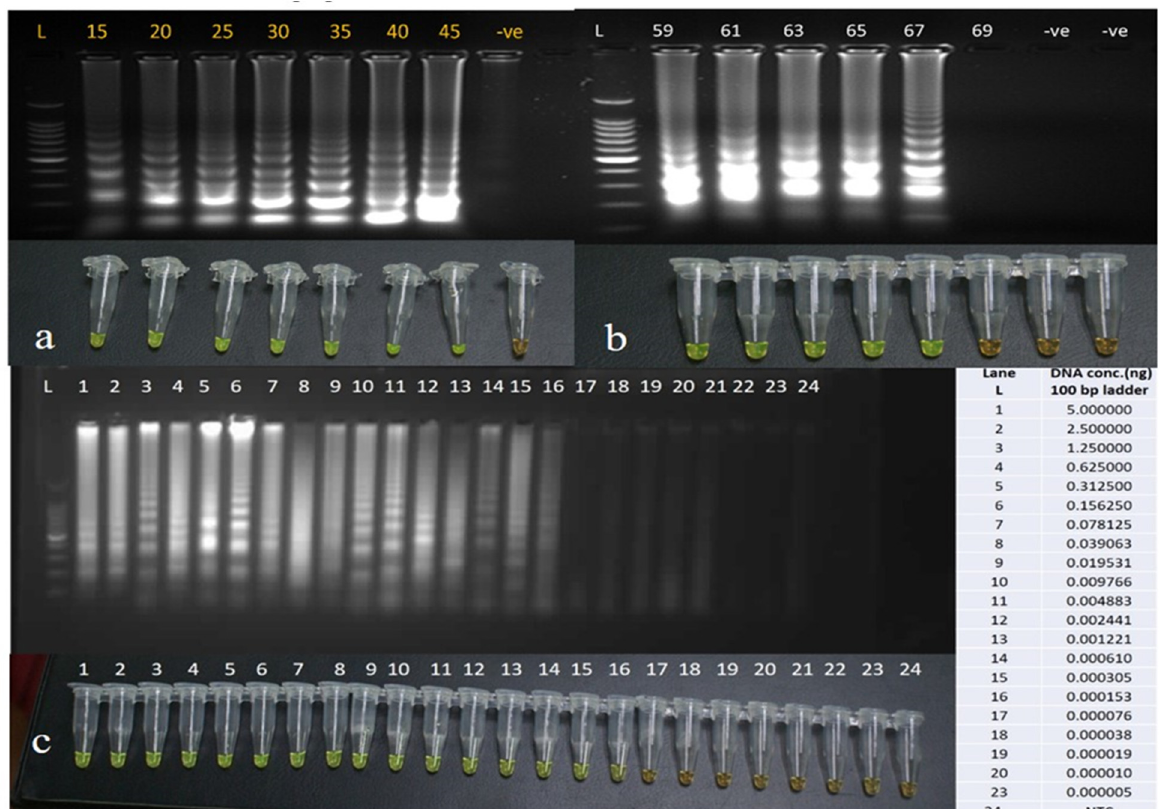
Figure 3. ( a ) Gel image and tubes of LAMP reaction showing naked eye visualization with SYBR green for standardization of time for amplification. ( b ) Gel image and tubes of LAMP reaction showing naked eye visualization with SYBR green for the standardization with different temperatures ranging from 59 to 69 °C. ( c ) Gel image and tubes of LAMP reaction showing visualization with the naked eye with SYBR green for standardization with different concentration of genomic DNA ranging from 5 ng to 0.000005 ng. L- 100 base pair ladder/marker, -ve–Negative control.